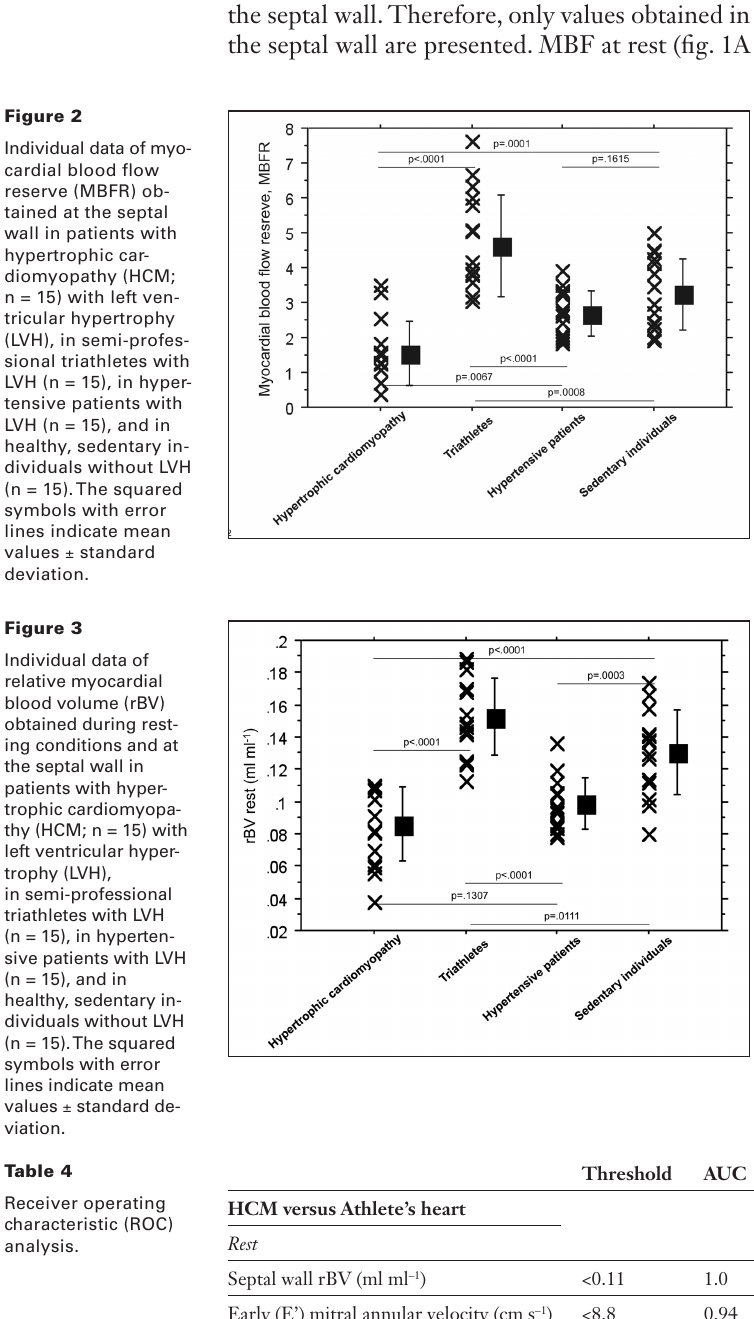
Receiver operating characteristic (ROC)